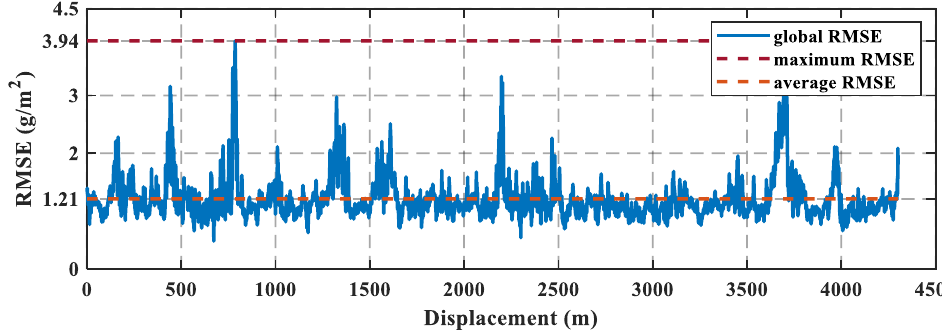
Figure 21. Prediction RMSE of the NARNN.